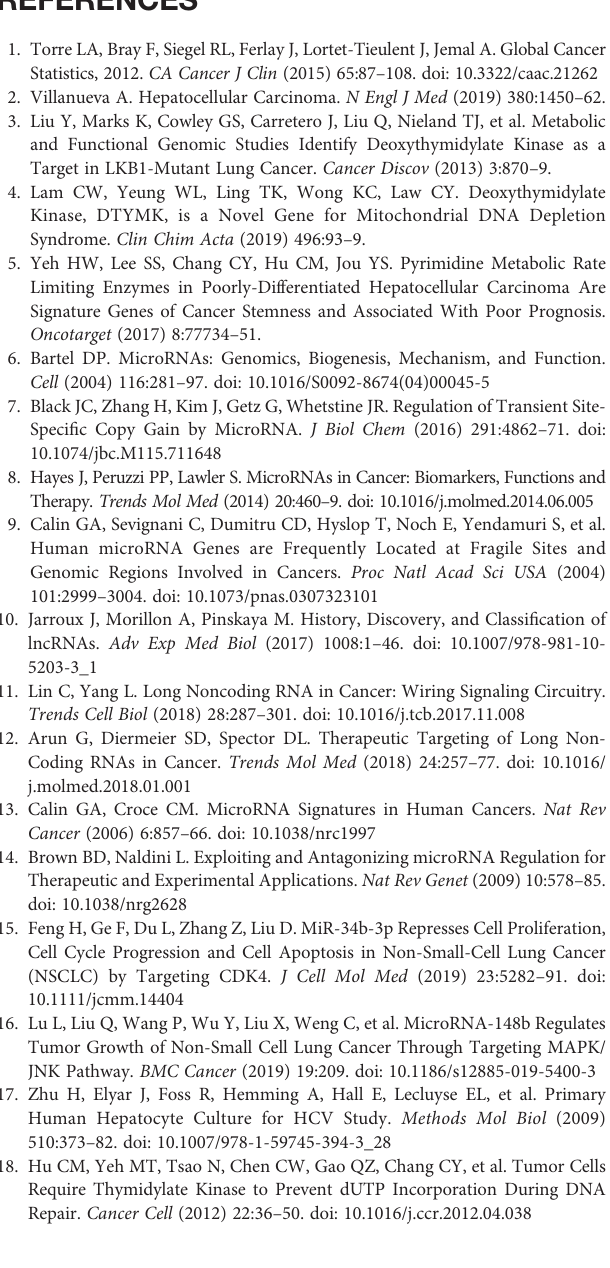
Scalebar, 100 µm. (B) QRT-PCR was assessed to assess miR-148b-3p expression